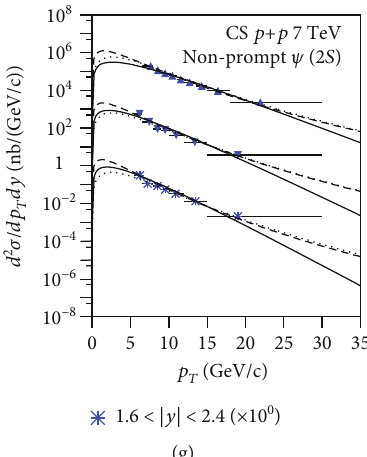
dy and (b) d σ / dp ψ ð 2 S Þ from di ff erent production modes in (a) p + (cid:1) p , (b) Figure 3: Transverse momentum spectra, (a, c – g) d 2 σ / dp T T , of p + Pb , and (c – g) p + p collisions at energies (a) 1.8 and 1.96, (b) 5, (c – e) 5.02, and (f – g) 7 TeV. The di ff erent symbols represent the experimental data of the (a, c, e, and f) prompt ψ ð 2 S Þ , (b) inclusive ψ ð 2 S Þ , prompt ψ ð 2 S Þ , and ψ ð 2 S Þ from b , and (d, g) non-prompt ψ ð 2 S Þ measured by the (a) CDF [15, 16], (b) LHCb [23], (c, d) ATLAS [28], and (e – g) CMS Collaborations [31, 32] in (a) p + (cid:1) p , (b) p + Pb , (c – g) ffiffi p p ffiffiffiffiffiffiffi s = (a) 1.8 and 1.96, (b) 5, (c – e) 5.02, and (f, g) 7TeV with (a) ∣ y ∣ <0 : 6 , (b) 1 : 5 < y < 4 : 0 , (c, d) 0 : 00 < ∣ y ∣ < p + p collisions at s or NN 0 : 75 , 0 : 75 < ∣ y ∣ <1 : 50 , and 1 : 50 < ∣ y ∣ <2 : 00 , (e) 0 < ∣ y ∣ <0 : 9 , 0 : 9 < ∣ y ∣ <1 : 5 , 1 : 5 < ∣ y ∣ <1 : 93 , and 1 : 93 < ∣ y ∣ <2 : 4 , and (f, g) ∣ y ∣ <1 : 2 , 1 : 2 < ∣ y ∣ <1 : 6 , and 1 : 6 < ∣ y ∣ <2 : 4 , where di ff erent collaborations have used di ff erent precisions for the rapidity intervals. Some data points are scaled by di ff erent amounts marked in the panels. The solid, dashed, and dotted curves represent our results fi tted by the (two-component) Erlang distribution (Eq. (3)), the Hagedorn function (Eq. (4)), and the Tsallis-Levy function (Eq. (6)),